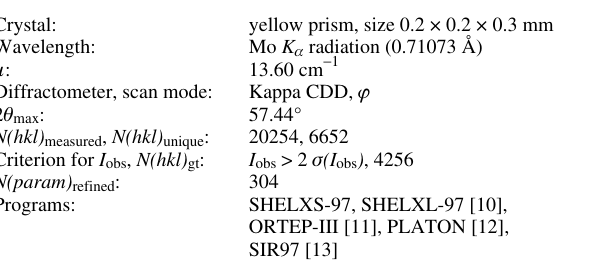
Table 1. Data collection and handling.